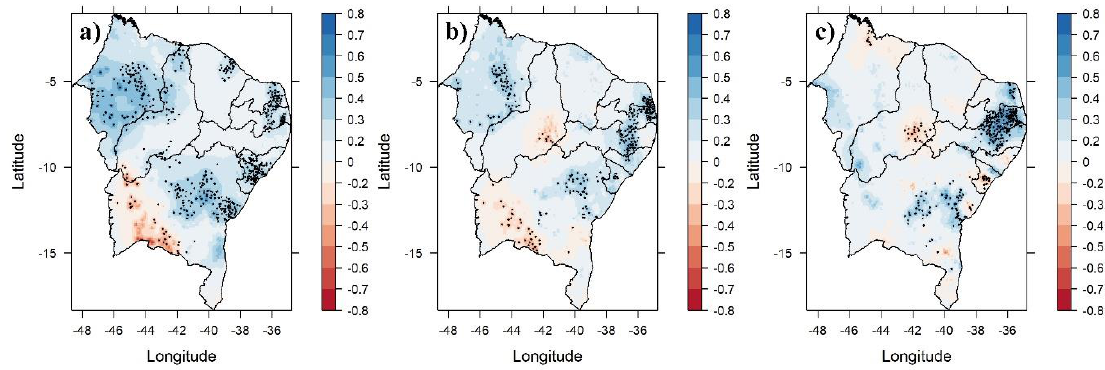
Figure 6. Trend of SPEI-3 / decade for the MJJ quarter in quantiles ( a ) Q5, ( b ) Q50, and ( c ) Q95. The black points indicate municipalities whose series presented statistical significance.